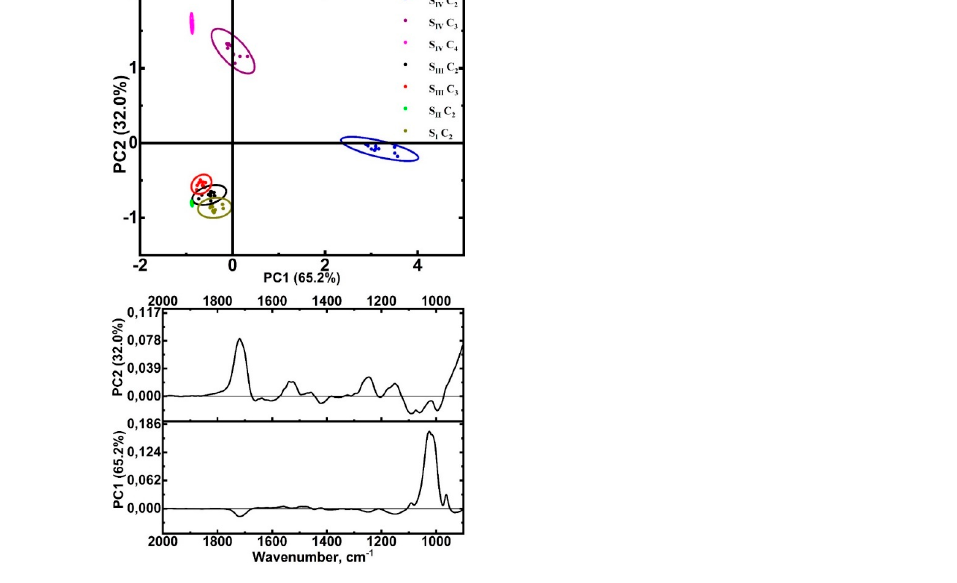
Figure 8. Results of the PCA analysis of interface zone components (clusters) for all samples studied. Above is the PCA scores plot (PC1 vs. PC2), and below are the PC loading plots for the PC1 and PC2.